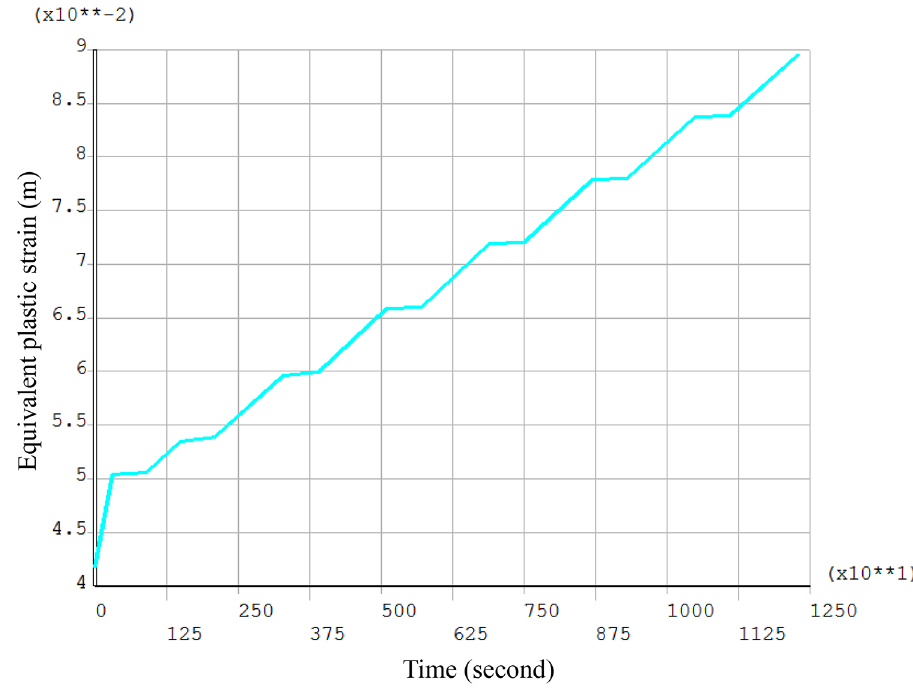
Fig. 8. Plastic strain history.